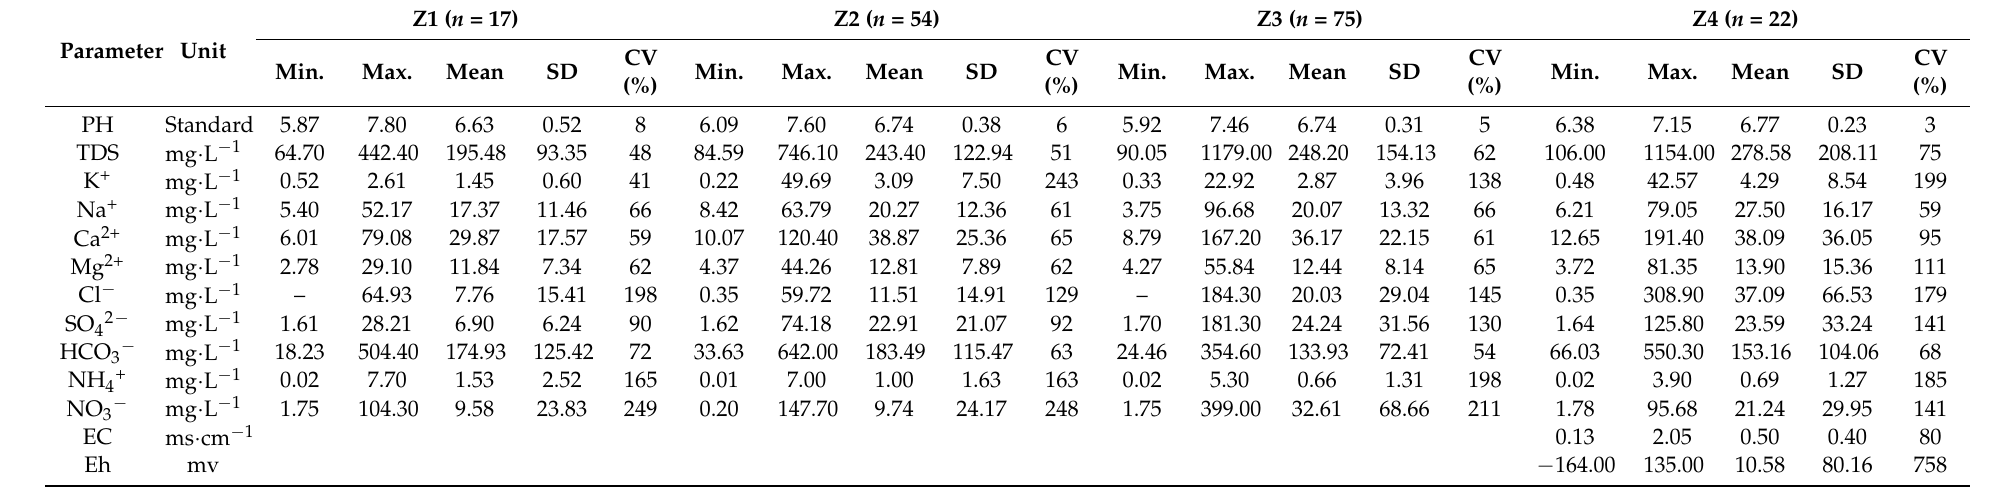
Table 1. Statistics of groundwater chemistry data in four zones of Muling–Xingkai Plain